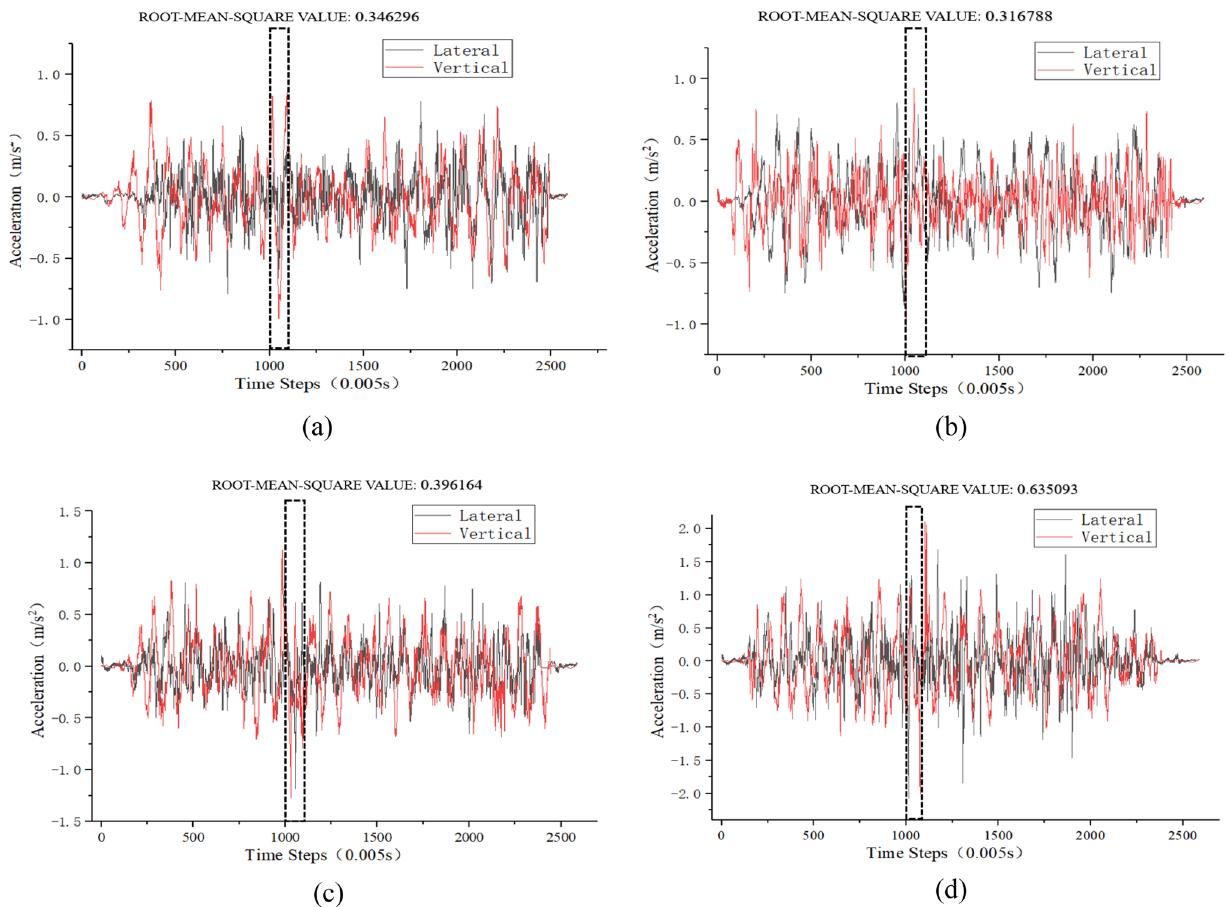
Fig. 9 Monorail vehicle acceleration under different wind speed. a wind speed = 0 m/s; b wind speed = 5 m/s; c wind speed = 10 m/s; d wind speed = 15